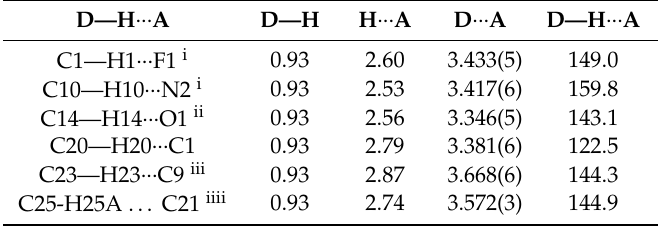
Table 1. Hydrogen bond characteristics (Å, °) in the crystal of Compound ( 3 ).